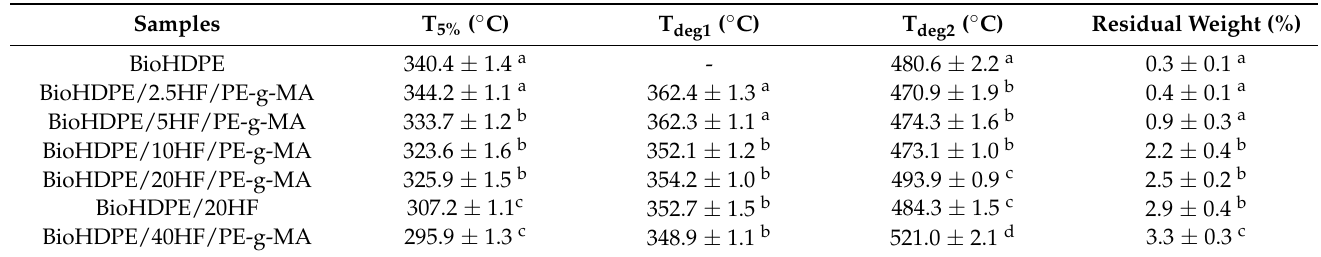
Table 5. Main thermal degradation parameters of the composites with different amounts of hemp fiber in terms of: Temperature at mass loss of 5% (T 5% ), degradation temperature (T deg ), and residual mass at 700 ◦ C.